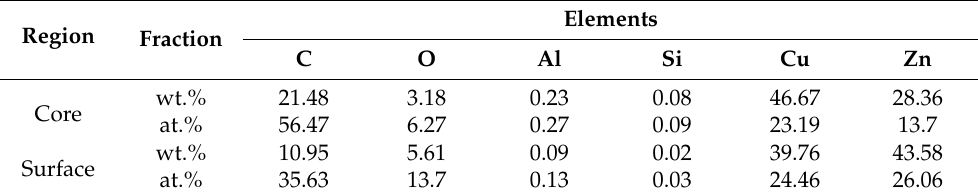
Table 4. EDS chemical composition of the core and the surface of the ZCSMWE.